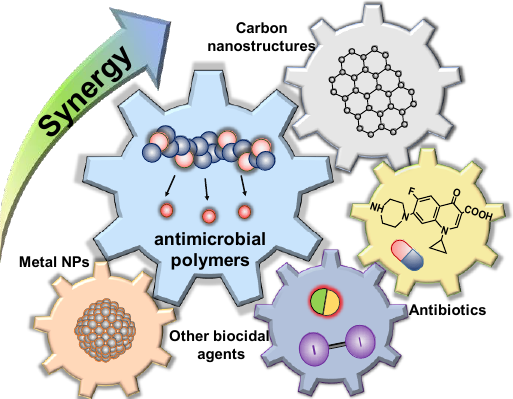
Figure 1. Schematic representation of multicomponent systems based on antimicrobial polymers for enhanced biocidal therapies.